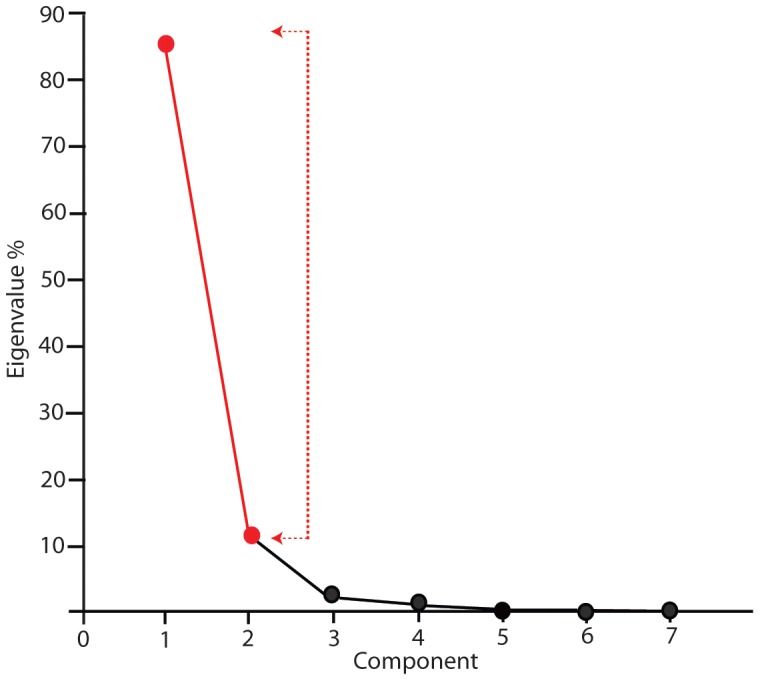
Scree plot indicating the first two plotted components in red, which account for 97.6% of the variance in the dataset.